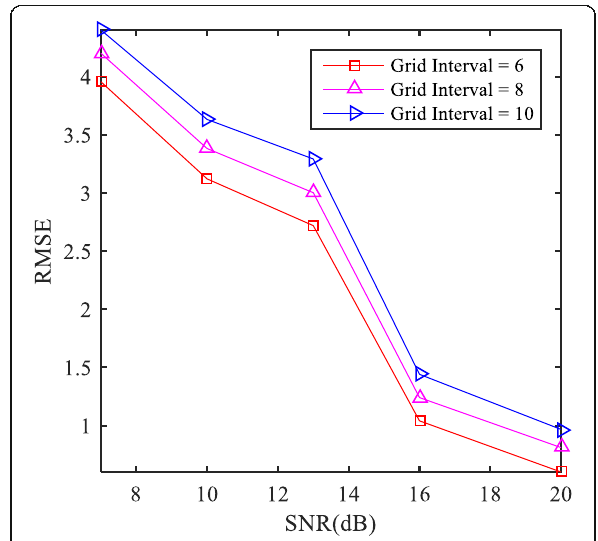
Fig. 14 RMSE as a function of SNR in the off-grid model with different grid interval